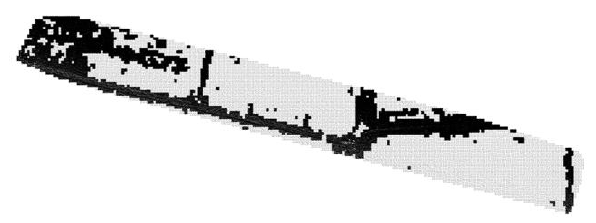
Figure 11. K-means clustering using City Block metric; results obtained for Block 4